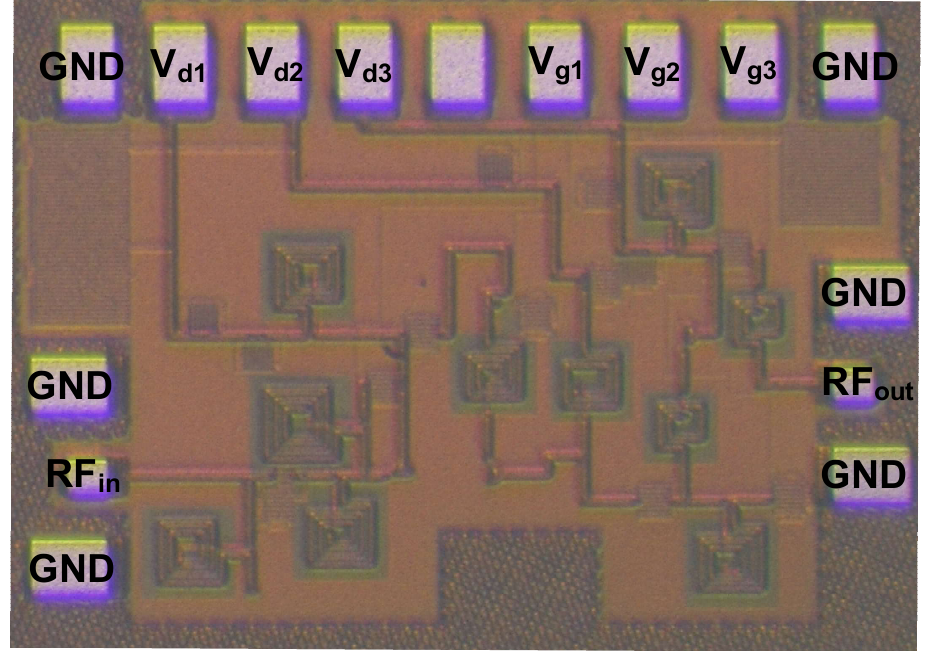
Figure 8. Chip micrograph of the full Ka-band amplifier.